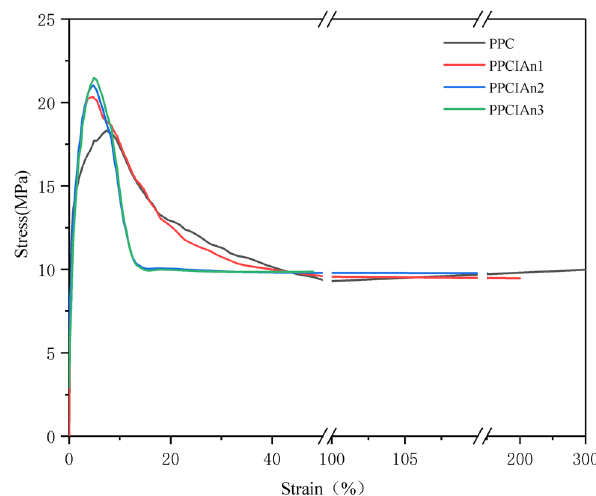
Figure 5: Strain – stress curves of PPC and PPCIAns.